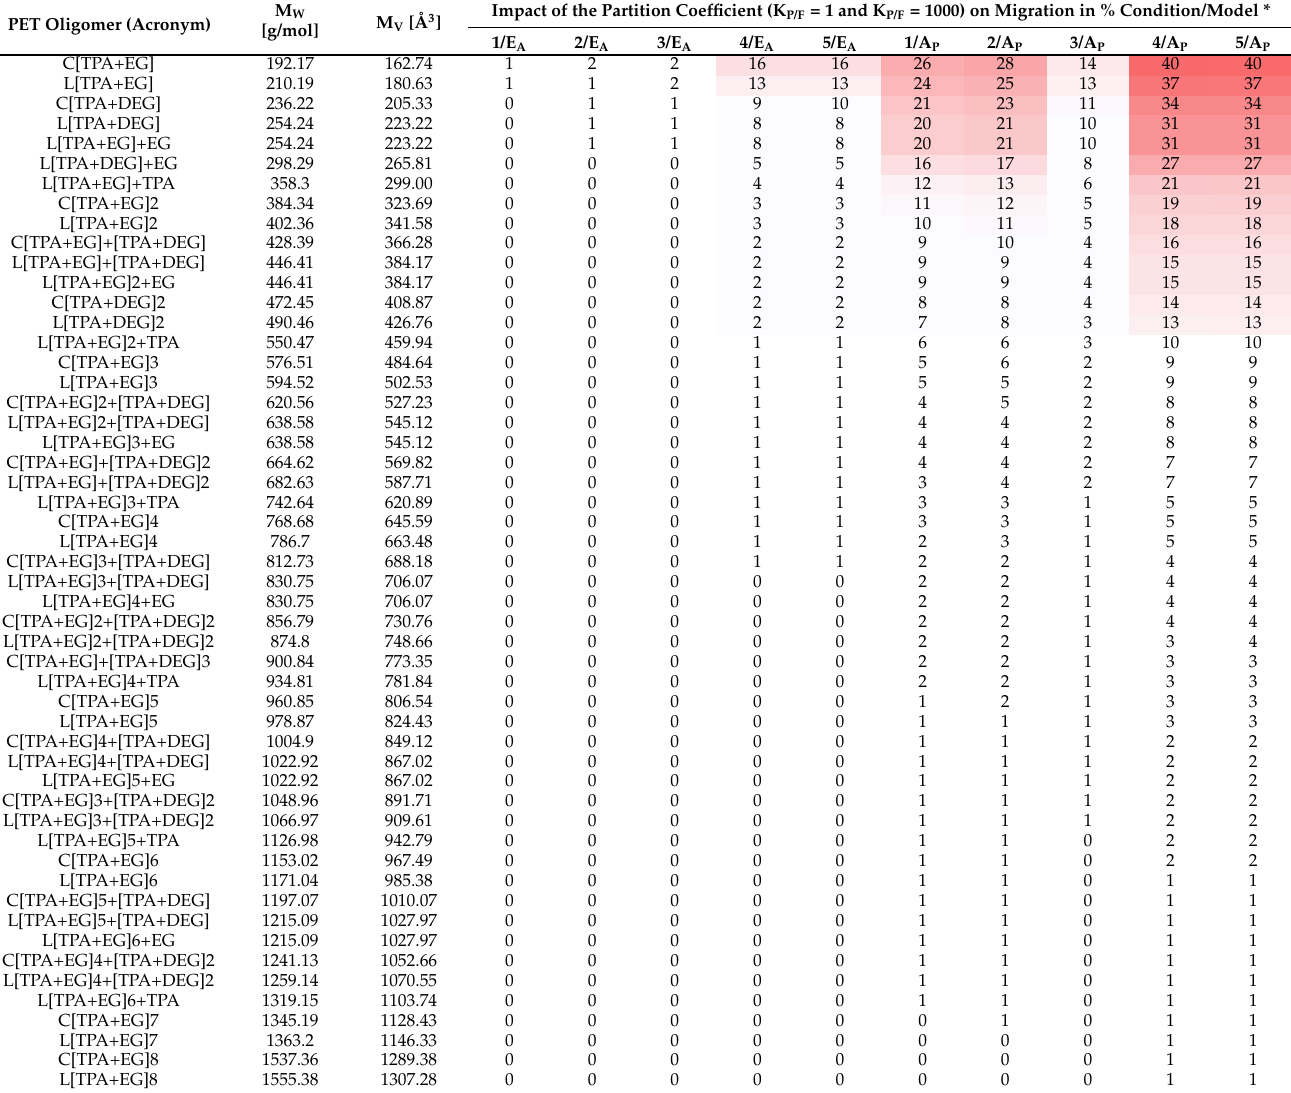
Table 3. Impact of partitioning at different conditions for PET oligomers predicted by the E A -based model or the A P model (realistic case). For each condition, the deviation of migration in mg/dm 2 between the partition coefficients K P/F = 1 and K P/F = 1000 is given in %. The color gradient indicates the impact of K P/F , with the influence increasing as the intensity of red